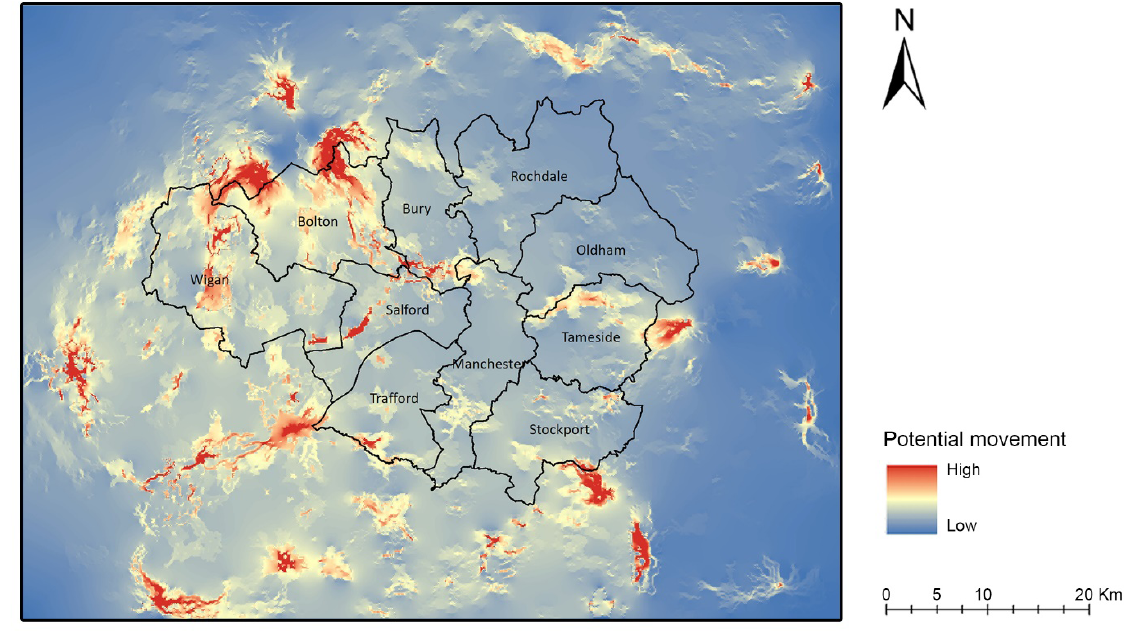
Figure 6. The integrated flows of forest migration in the study area.